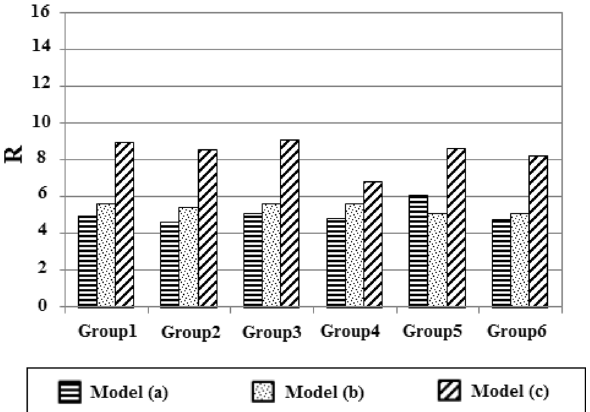
Fig. 19 Computational ratio of the response modification factors of models with multiple Vierendeel panels to those of models with a Vierendeel panel